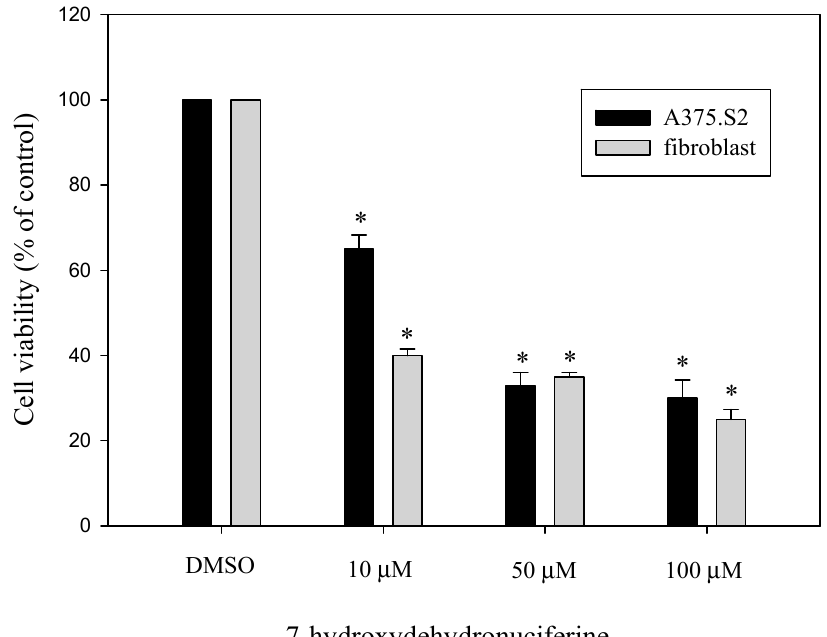
Figure 2. Anti-proliferative effects of compounds on A375.S2 and human dermal fibroblasts cells. Cell growth was determined by a MTT assay after incubation with 10, 50, 100 μ M of 7-hydroxydehydronuciferine ( 10 ), respectively. Results are expressed as the percent of the cell proliferation of the vehicle control at 24 h. Values are expressed as means ± S.D. of n = 3. * p < 0.05 versus DMSO